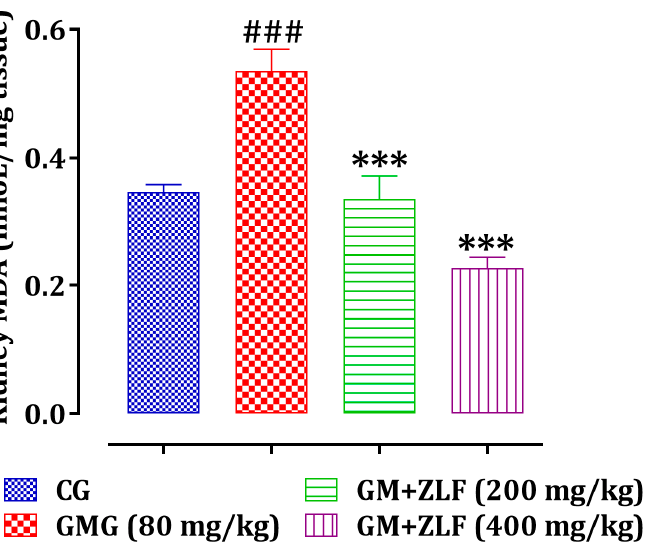
Figure 8. Effect of ZLF’s on kidney MDA level in GM-intoxicated rats. The data are displayed as mean ± SEM, ( n = 6). ### p < 0.01 related to CG. *** p < 0.001 versus GMG. GM: gentamicin; CG: Control Group; GMG: GM treated